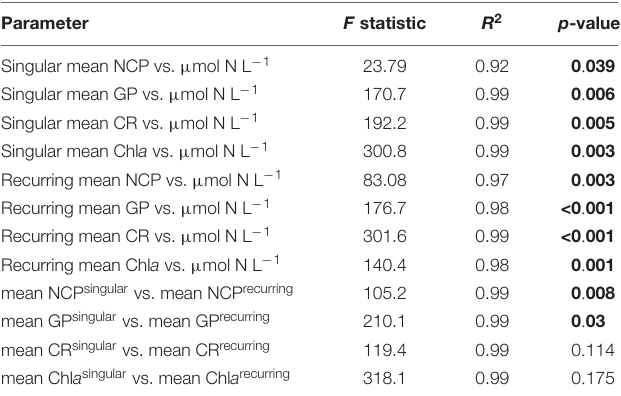
TABLE 2 | Linear regressions statistics of the relationship between productivity parameters (NCP, GP, CR, Chla) vs. upwelling intensity and for differences between upwelling